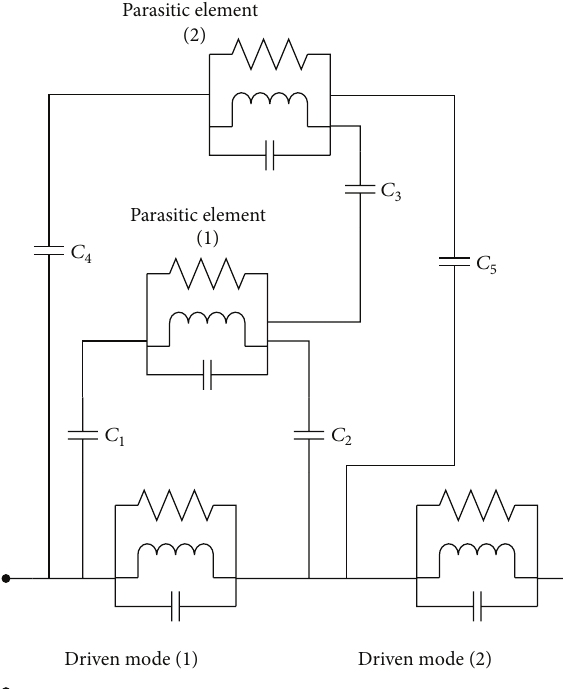
Figure 14: Electrical model of the parasitic element dual-mode C- band antenna.